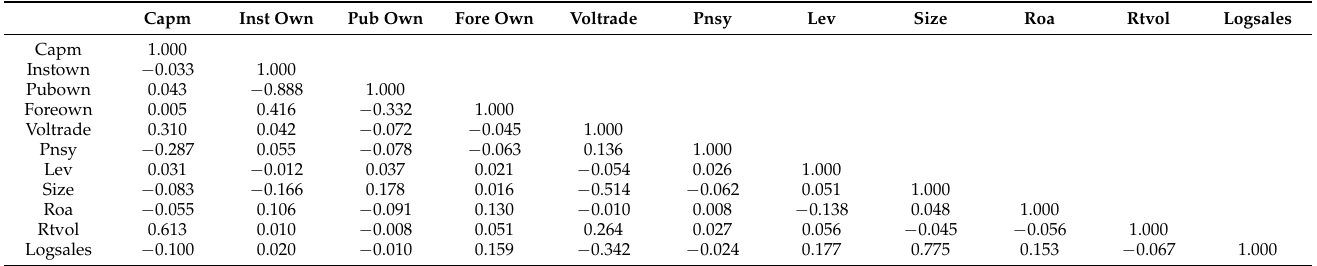
Table 3. Pearson